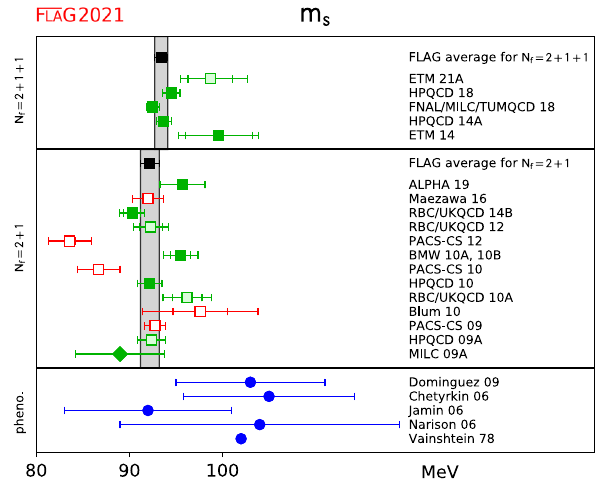
Fig. 1 MS mass of the strange quark (at 2 GeV scale) in MeV. The upper two panels show the lattice results listed in Tables 6 and 7, while the bottompanelcollectssumruleresults[205–209].Diamondsandsquaresrepresentresultsbasedonperturbativeandnonperturbativerenormalization, respectively. The black squares and the grey bands represent our averages (33) and (35). The significance of the colours is explained in Sect. 2